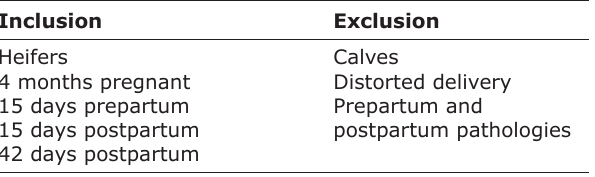
Table-1: Inclusion and exclusion